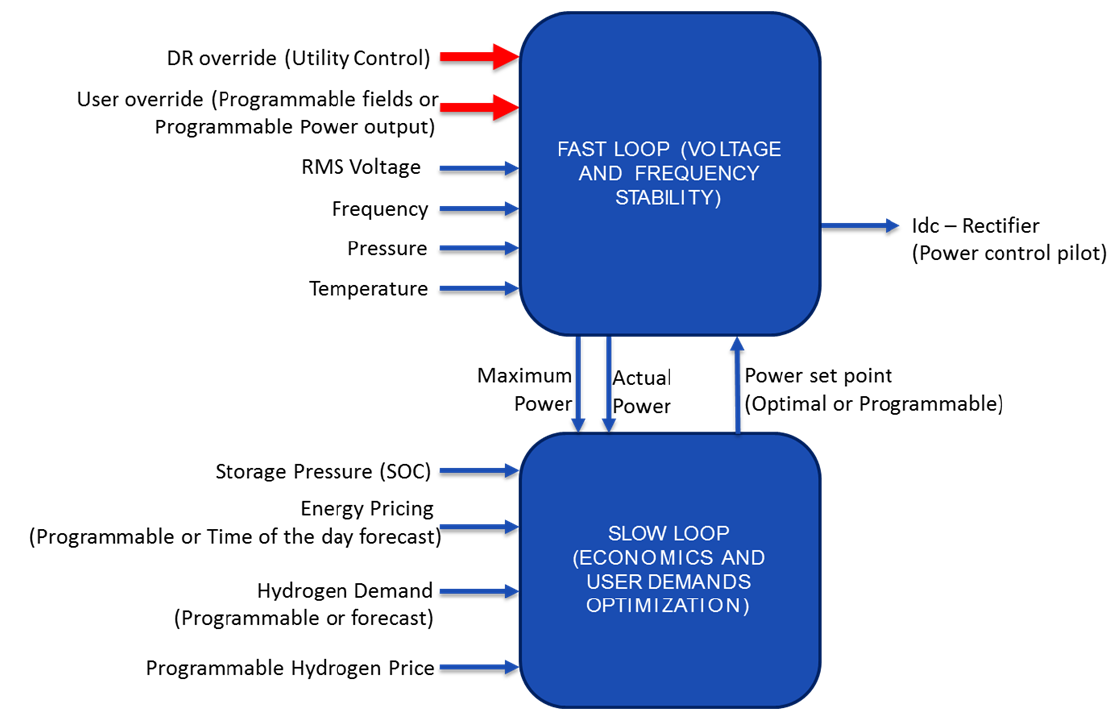
Figure 8. Detailed signals associated with the control loops of front end controller